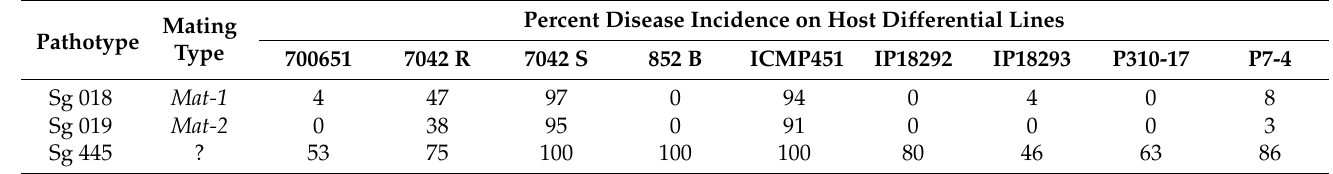
Table 3. Differential reaction of the isolates selected for developing F 1